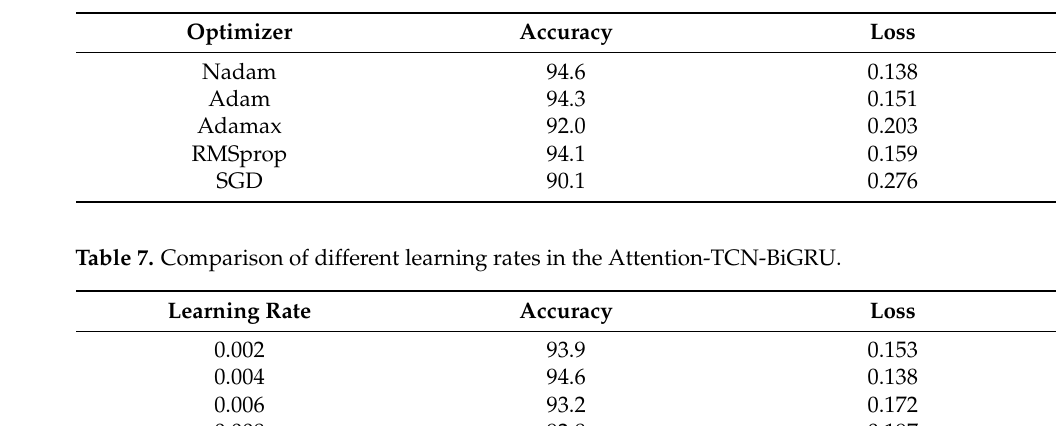
Table 6. Comparison of the different optimizers in the Attention-TCN-BiGRU.